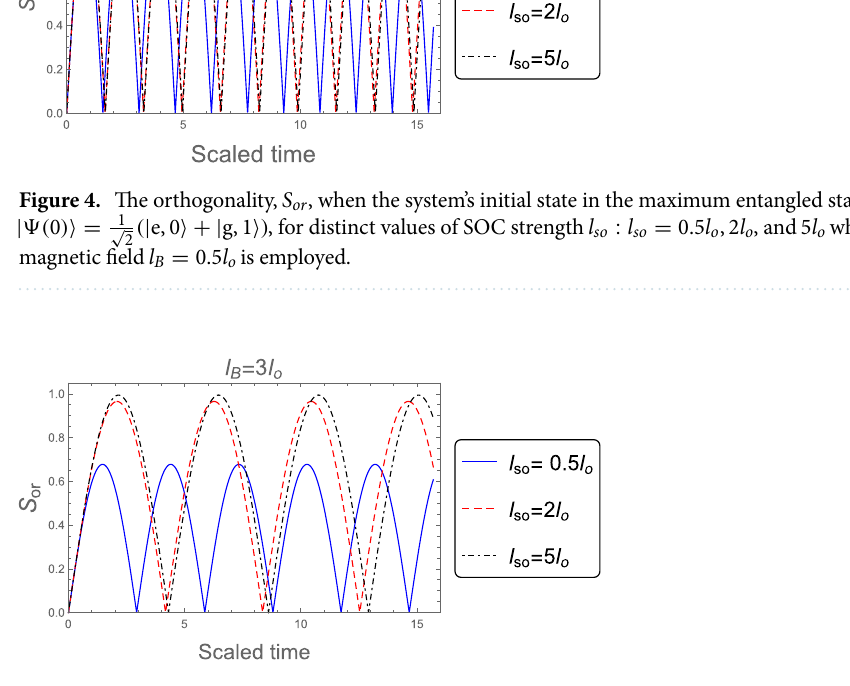
Figure 5. As Fig. 4, but when the weak magnetic field l B